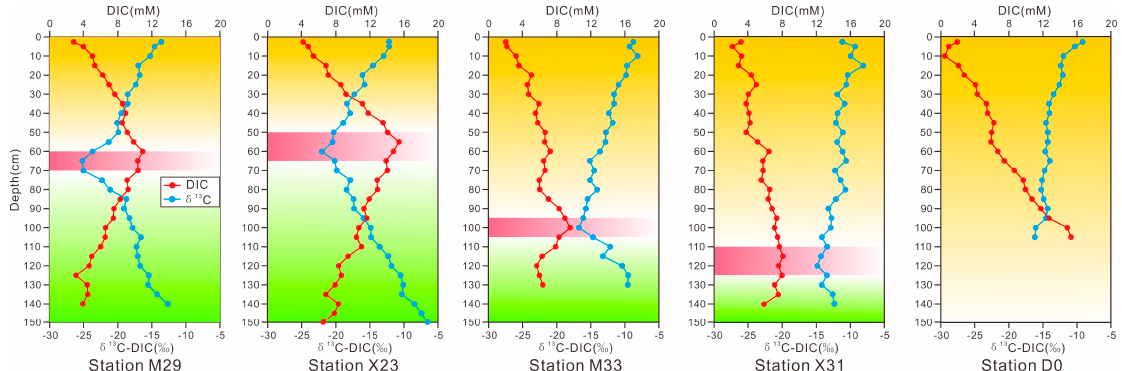
Figure 3. Concentration profiles of DIC and δ 13 C DIC in pore water. The sedimentary pore water δ 13 C DIC values at M29, X23, M33, and X31 showed rightward convex curves with peak negative carbon isotope values of −